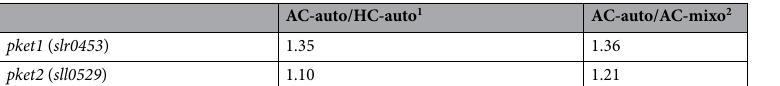
Table 2. Gene expression of phosphoketolases annotated for Synechocystis . Transcriptomic data were taken from 16 (1) and 18 (2). AC-auto, HC-auto and AC-mixo denotes the growth conditions, ambient CO 2 autotrophic, high CO 2 autotrophic and ambient CO 2 mixotrophic state,